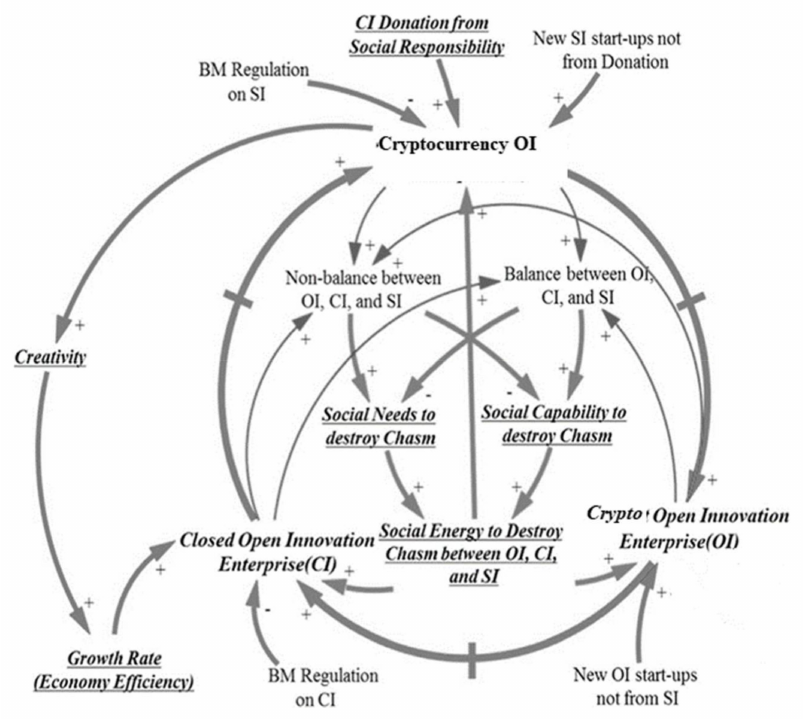
Figure 1. Open innovation dynamics. (Source: designed by authors on the base of the paper [13]). The evolution of knowledge sharing processes and mechanisms best reflects the